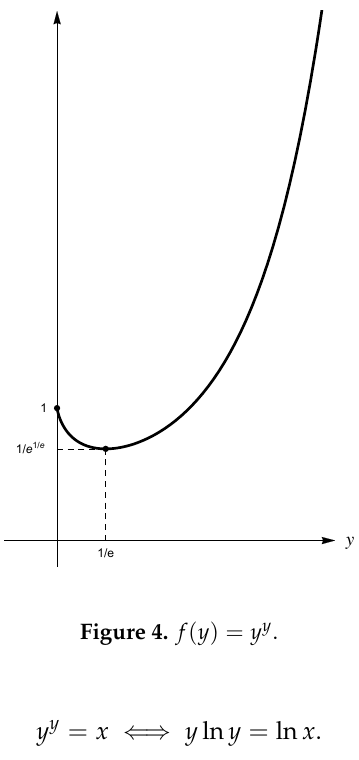
Figure 4. f ( y ) = y y